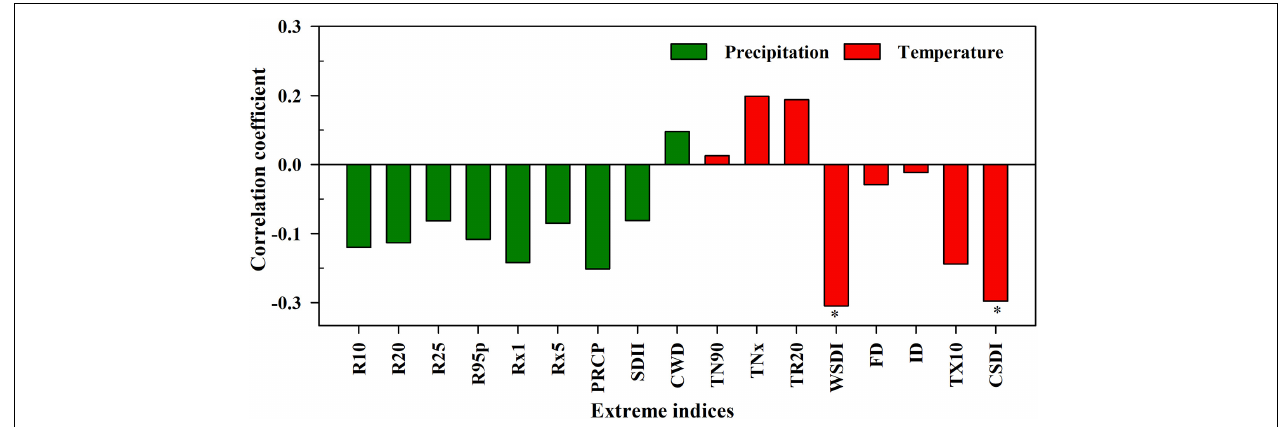
FIGURE 9 | Correlation coefficients of extreme climate indices and the tree-ring chronology of Malus sieversii in the degraded region.